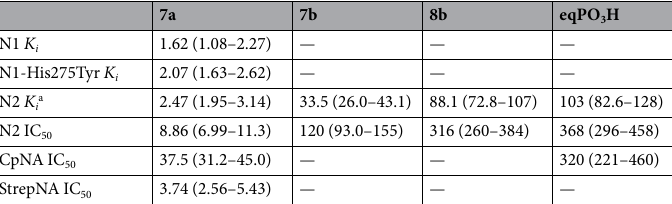
— — StrepNA IC 50 — — — Table 3. K i (inhibitory constant) and IC 50 (50% inhibition constant) values for the inhibition of N1, N2, CpNA, and StrepNA. All values are given in μ m units and 95% confidence intervals are listed inside parenthesis. a Influenza N2 K i values were estimated using the Cheng-Prusoff equation ( K i K m previously determined as 46.5 μ M 3 . Dashes ( − ) indicate that inhibition was not